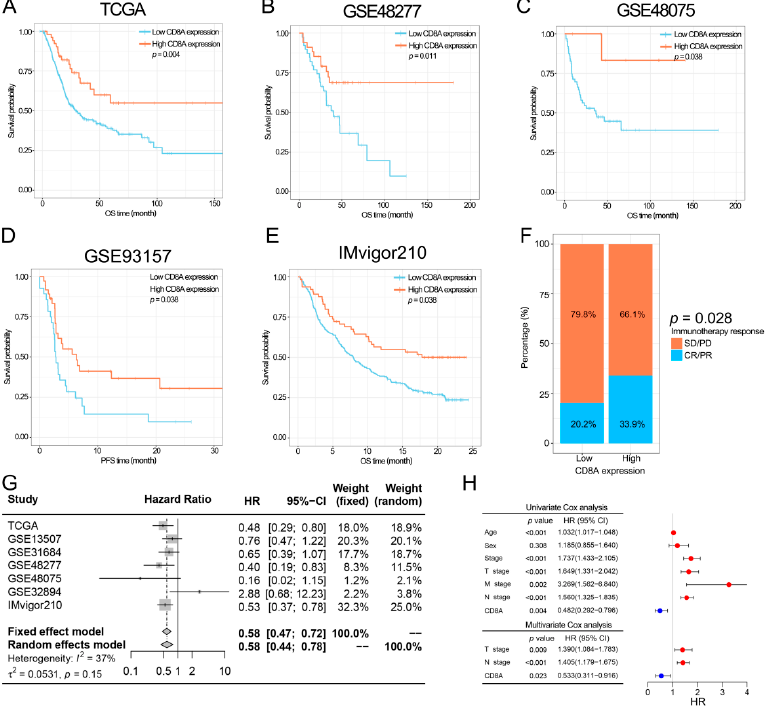
Figure 3. Investigating the clinical predictive value of CD8A in prognosis and immunotherapeutic response. ( A – E ) Kaplan–Meier plots of CD8A in five datasets, including TCGA ( A ), GSE48277 ( B ), GSE48075 ( C ), GSE93157 ( D ) and IMvigor210 ( E ). ( F ) Percentages of the different PD-L1 inhibitor responses between high or low CD8A expression groups in IMvigor210. ( G ) Forest plot of the HRs for patients with high CD8A expression compared to patients with low CD8A expression in seven BCa datasets. ( H ) Univariate and multivariate Cox analyses in TCGA-BCa. OS, overall survival; PFS, progression-free survival; CR, complete response; PR, partial response; SD, stable disease; PD, progressive disease; HR: hazard ratio; TCGA: The Cancer Genome Atlas; BCa, bladder cancer.